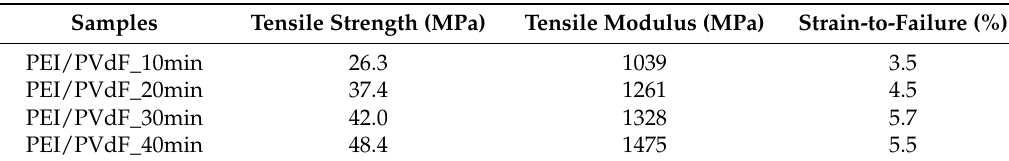
Table 2. Tensile properties of the post-treated PEI/PVdF membranes.